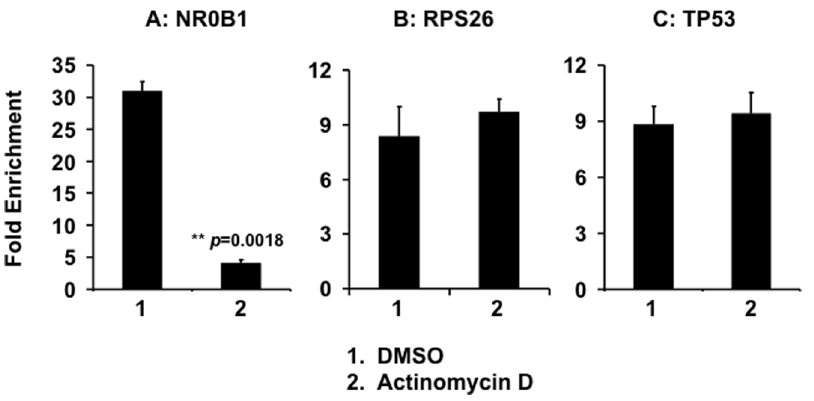
Figure 4. Effects of actinomycin D on the binding of EWS-FLI1 to the NR0B1 promoter. EWS-FLI1 was immunoprecipiatated using a FLI1 antibody, and quantitative PCR used to determine binding to NR0B1, RPS26, and p53. Data expressed as fold-enrichment over normal IgG control ChIP. Data plotted as mean + / 2 SD of duplicates are representative of 3 independent experiments.